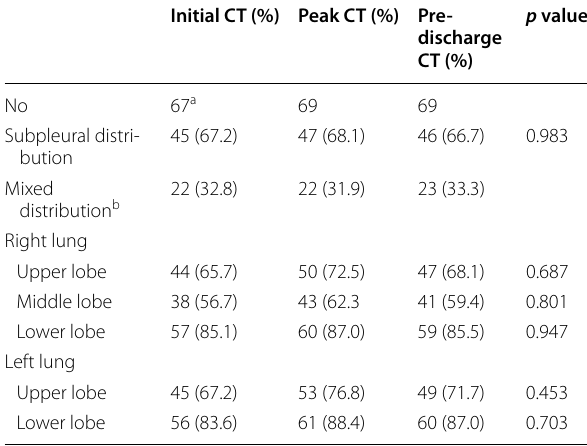
a Two of 69 patients show no COVD-19 on CT b Mixed distribution distribution of subpleural and bronchovascular bandle =